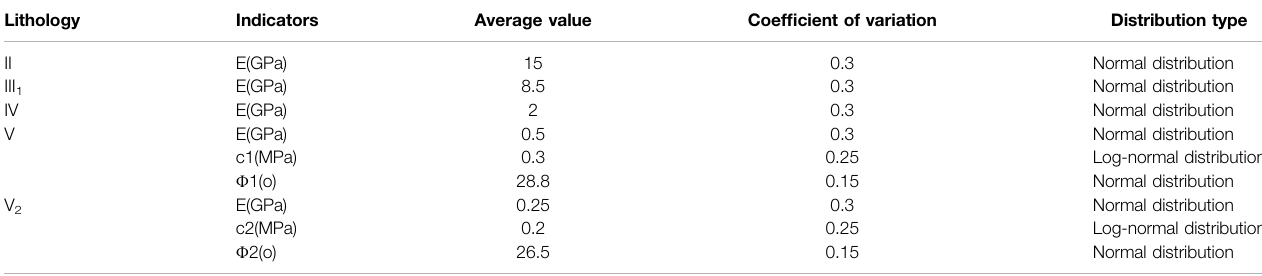
TABLE 7 | Rock material parameters of the slip fracture surface.